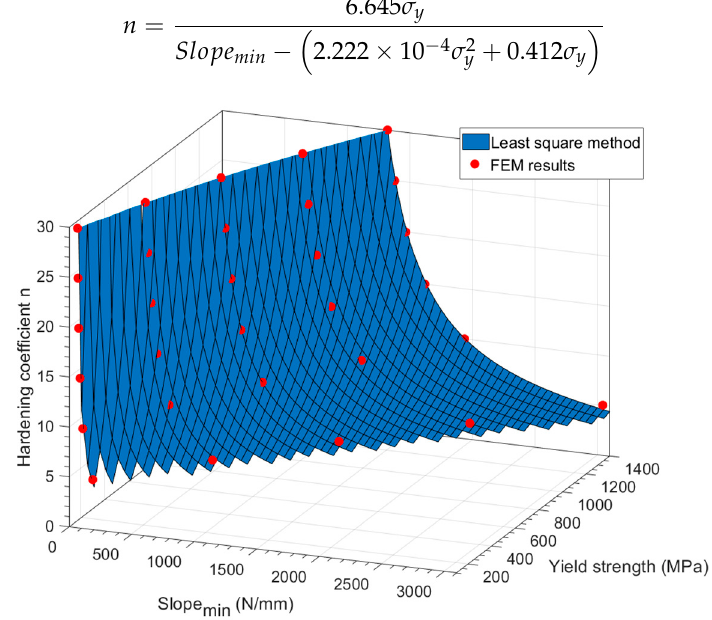
Figure 11. Correlation obtained from Matlab ® .